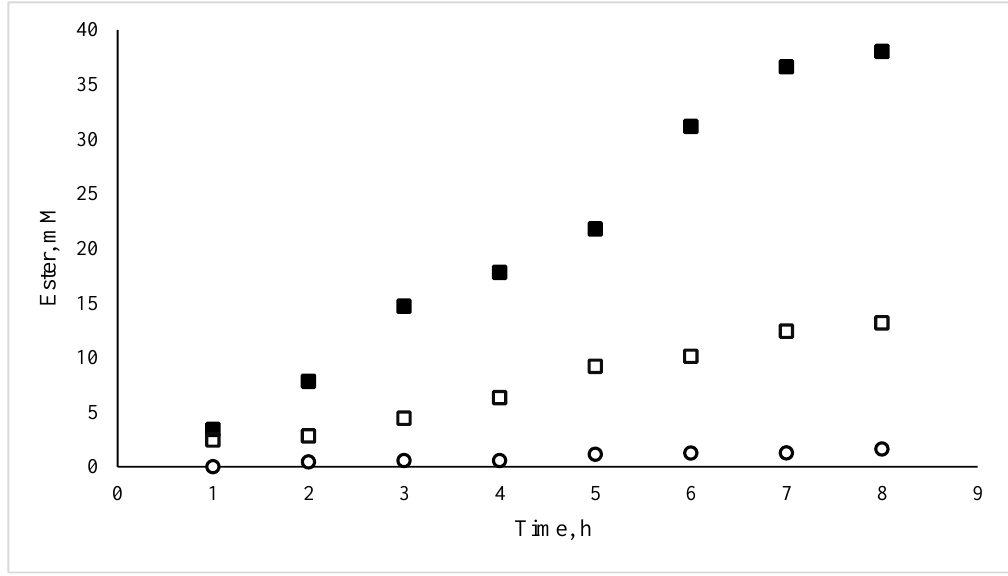
Figure 1. Effect of microemulsion-based gels (MBG) preparation on the rate of propyl laurate synthesis, catalyzed by C. rugosa lipase. [1-propanol], [lauric acid]: 100 mM, each; isooctane as solvent (10 mL); C. rugosa content per MBG 0.3 mg. ( ■ ): (hydroxypropyl)methyl cellulose (HPMC)-based MGB;